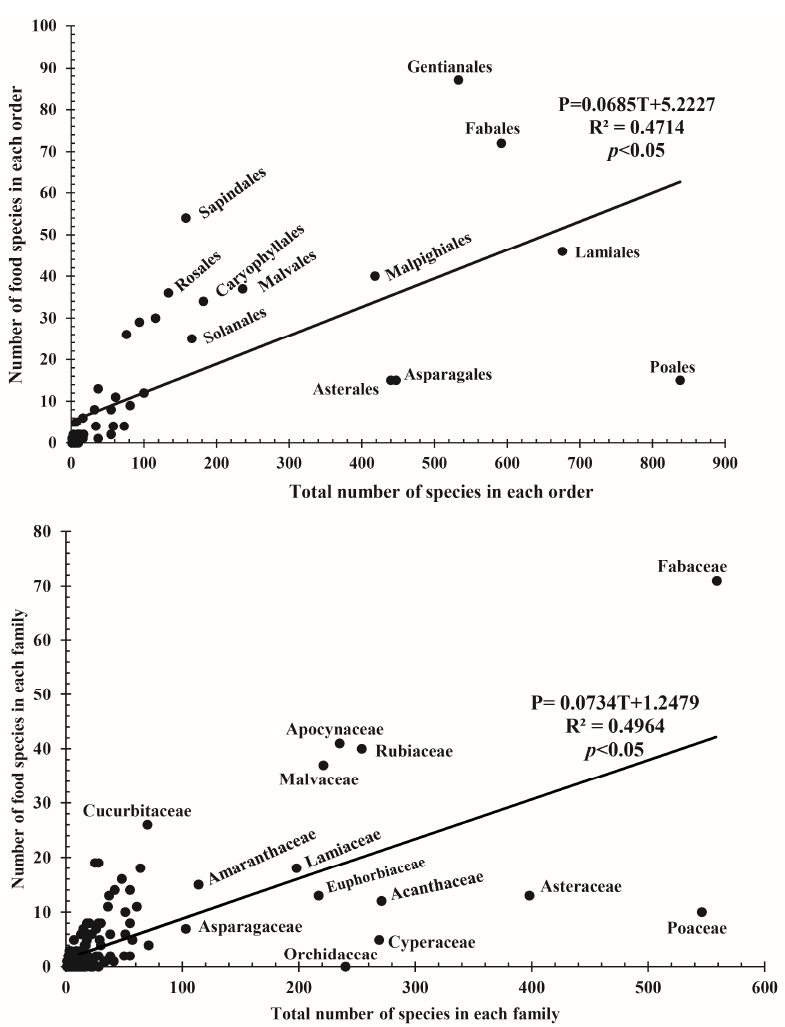
Figure 2. Linear regression model showing the relationship between the number of food species and the total number of species for orders and families. Table 3. Quantitative analysis of food orders. T—total number of species in the flora; F—food species; ↑ / ↓ —positive/negative outliers based on residuals; P a —predicted food species under regression model; Res.—regression residuals; P b —predicted food species under binomial model; inf.—Bayesian inferior 95% probability credible intervals; sup.—Bayesian superior 95% probability credible intervals; *—positive